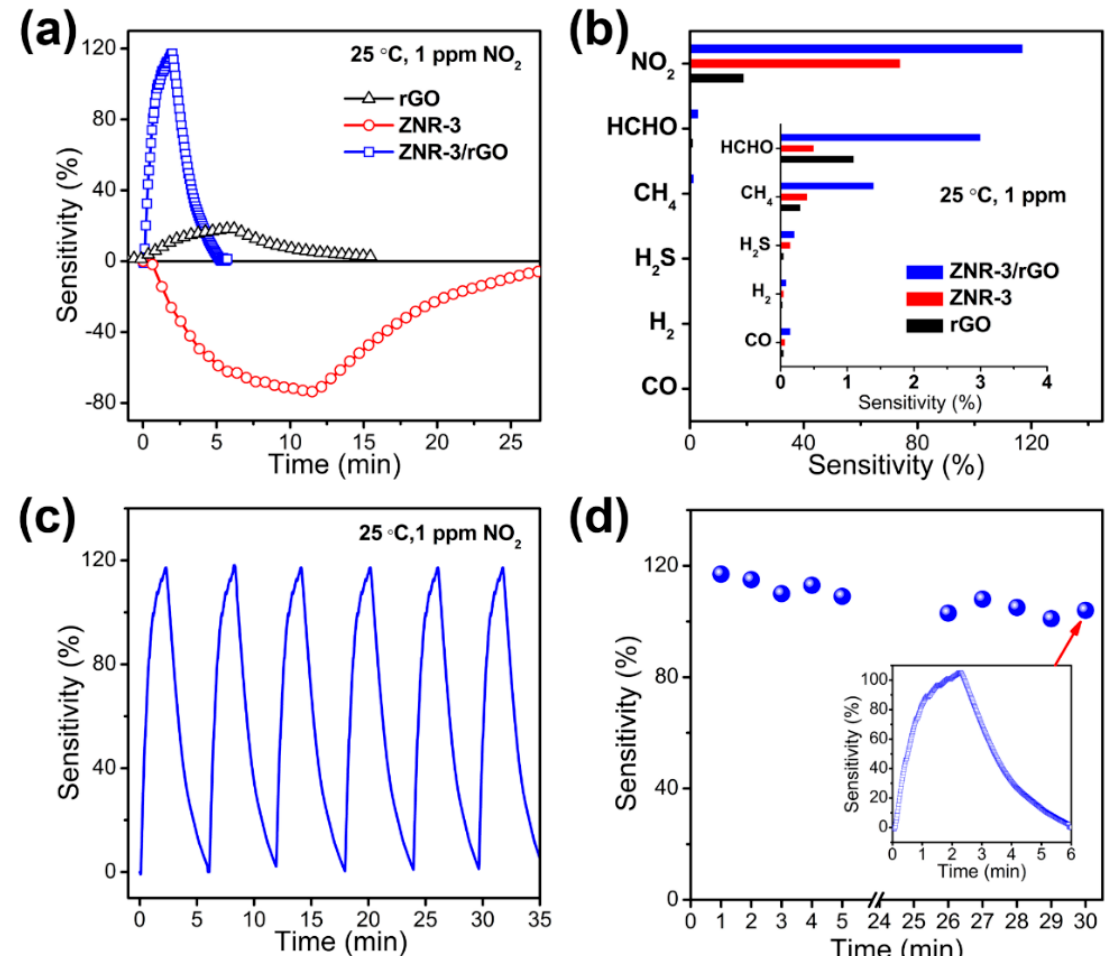
Figure 11. ( a ) dynamic response of rGO, UT-ZNR, and rGO/UT-ZNR; ( b ) sensitivities rGO, UT-ZNR, and rGO/UT-ZNR; ( c ) reproducibility of the rGO/UT-ZNR sensor; ( d ) stability of the rGO/UT-ZNR sensor in air for 30 days. Reproduced with permission from [65] © 2016 American Chemical Society.